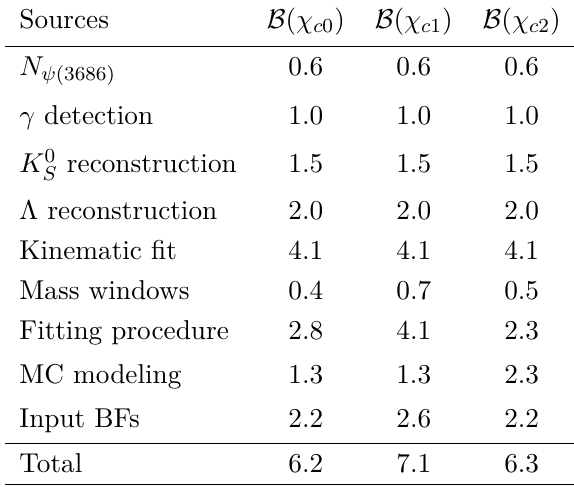
Table 2 . Systematic uncertainty sources and their contributions (in